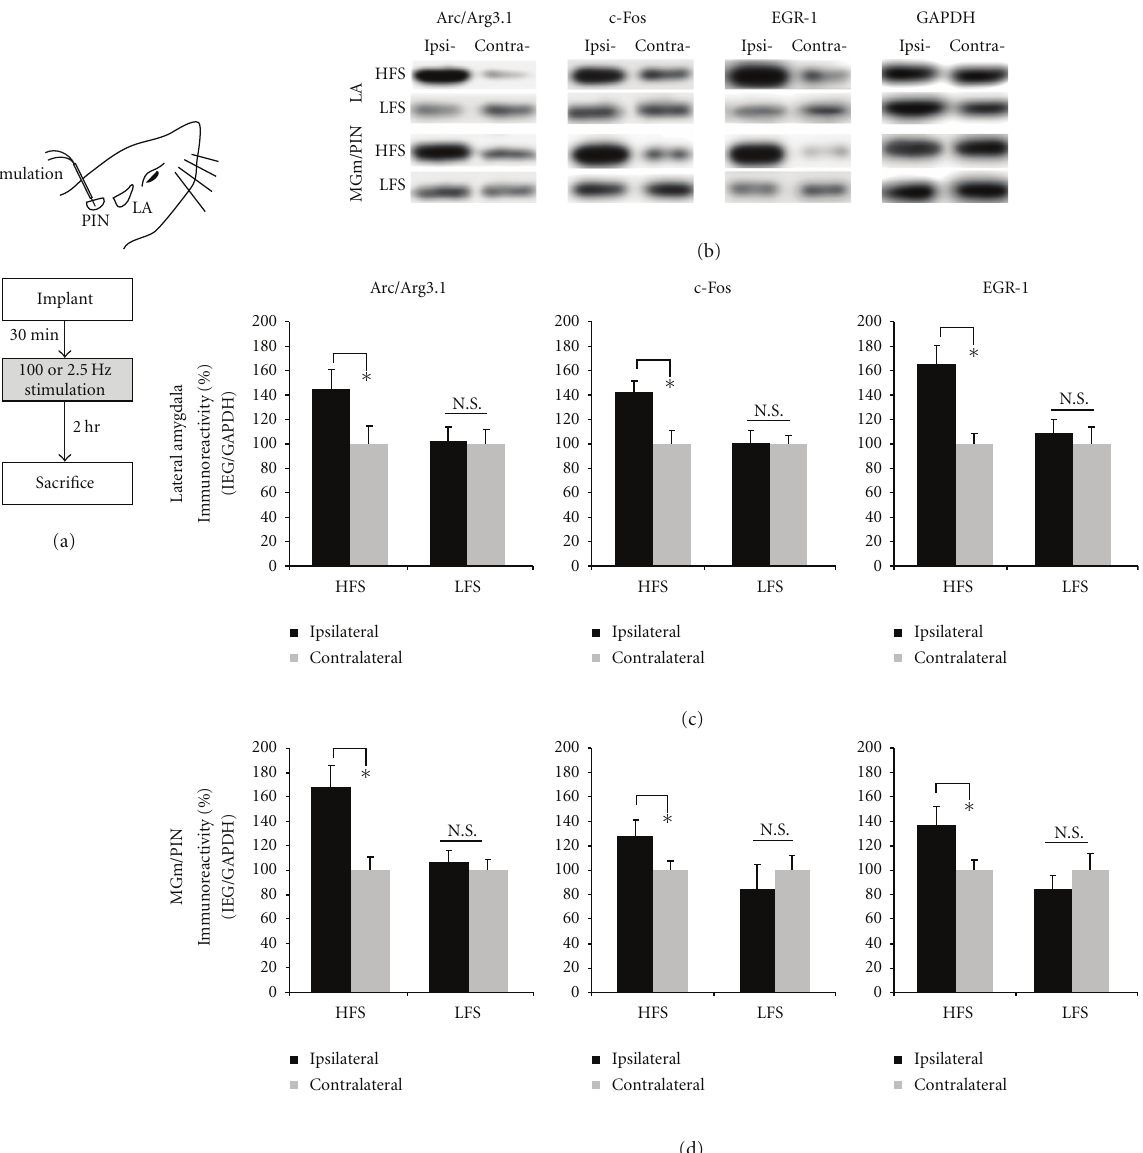
Figure 2: High-frequency stimulation of the MGm/PIN promotes ERK-driven IEG expression in both the LA and MGm/PIN. (a) Placement of stimulation electrode and schematic of the experimental protocol. Rats were given HFS or LFS and sacrificed 2 hours after stimulation. (b) Images of Western blots for Arc/Arg3.1, c-Fos, EGR-1, and GAPDH from both LA (top) and MGm/PIN samples (bottom). (c) Mean ( ± SEM) percent IEG immunoreactivity from LA punches taken from rats given HFS ( n = 9) or LFS ( n = 9). (d) Mean ( ± SEM) percent IEG immunoreactivity from MGm/PIN punches taken from rats given HFS ( n = 9) or LFS ( n = 9). In each figure, IEG levels have been normalized to GAPDH for each sample, and IEG expression on the ipsilateral side has been expressed as a percentage of that on the contralateral side for each rat. ∗ P < . 05 relative to the ipsilateral side N.S. = not